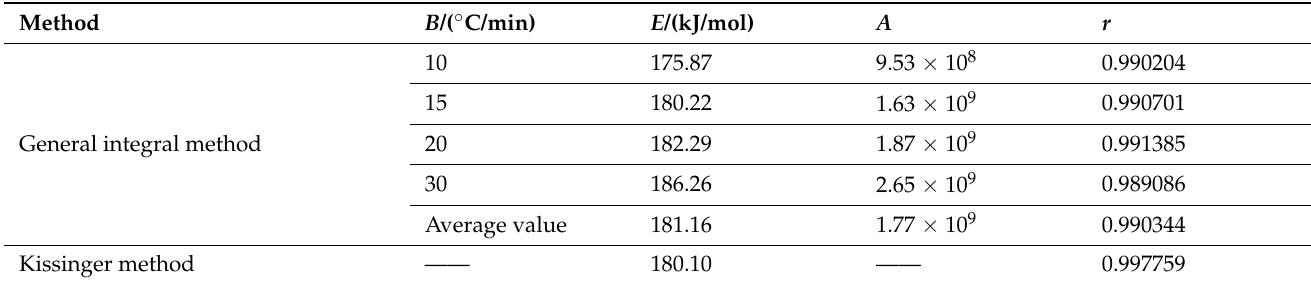
Figure 7. Kinetic fitting curves of the ( a ) general integral and ( b ) Kissinger methods. Table 3. Reaction kinetics fitting results.